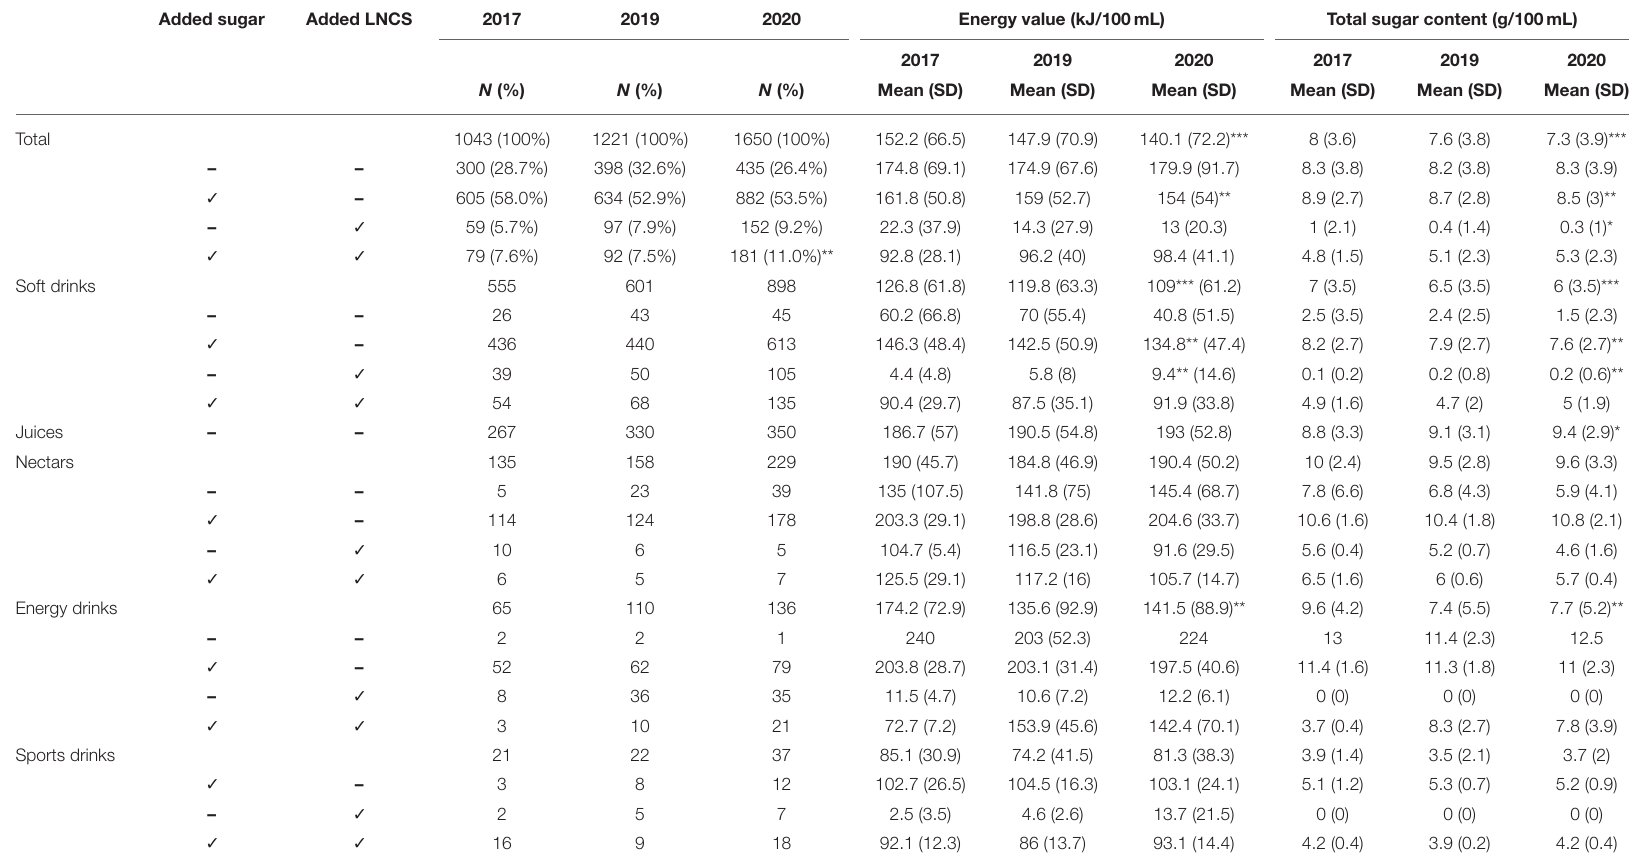
TABLE 2 | Comparison of the energy value and total sugar content in non-alcoholic beverages, based on the presence of added sugar and low and/or no-calorie sweeteners (LNCS). Added